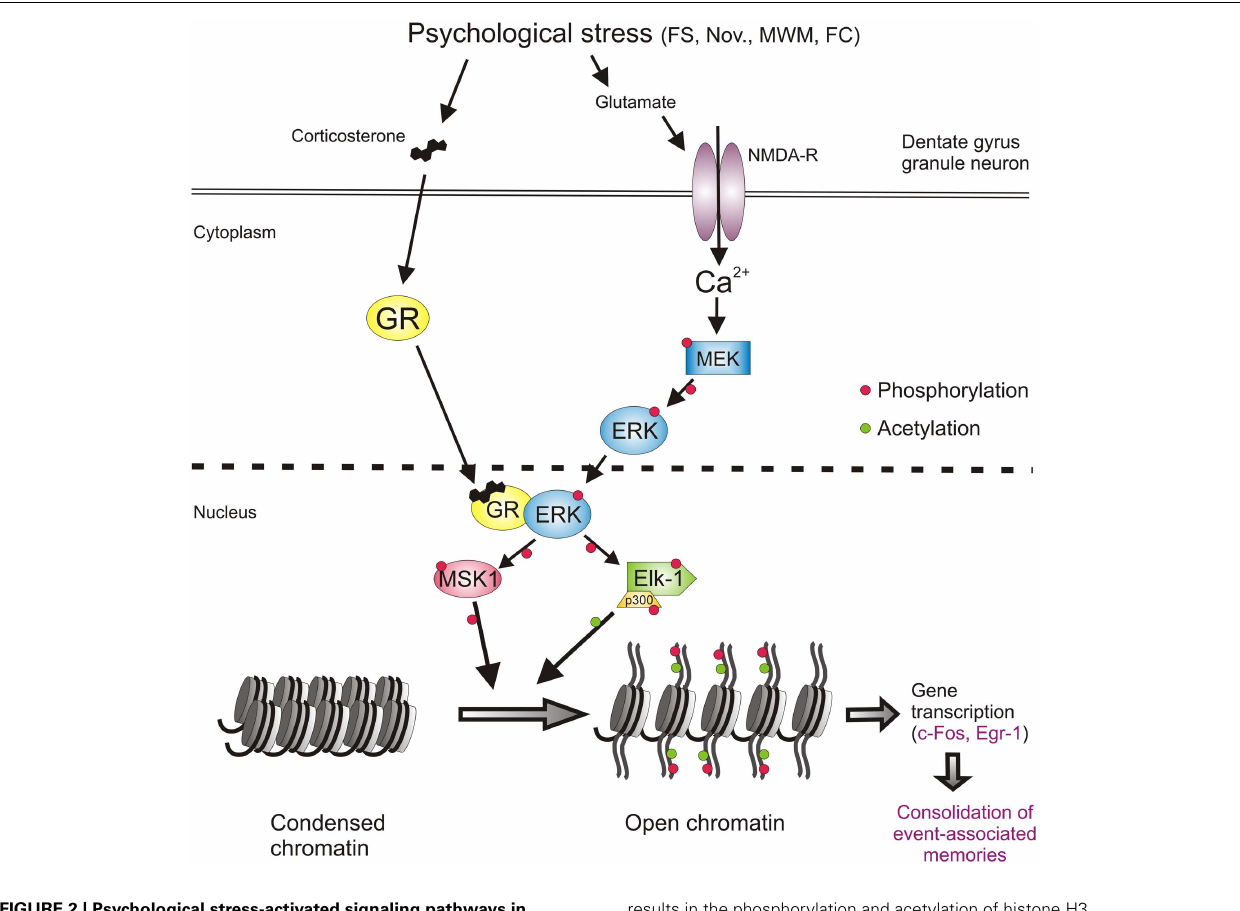
FIGURE 2 | Psychological stress-activated signaling pathways in dentate gyrus granule neurons driving epigenetic modifications underlying induction of gene transcription and the consolidation of behavioral responses and memory formation . Psychological stress evokes the concomitant activation of the GR and NMDAR-ERK-MAPK pathways.The concomitant activation of ERK1/2 and GR and their subsequent physical interaction facilitates the ability of pERK1/2 to phosphorylate MSK1/2 and Elk-1. Activation of these nuclear kinases